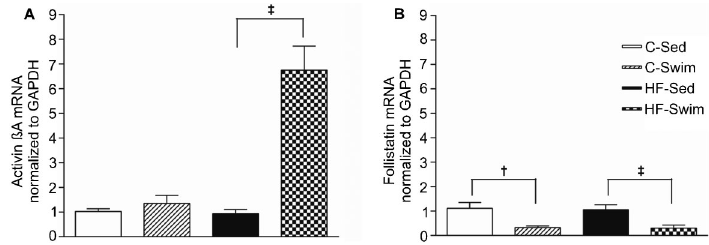
Figure 3. Liver expression mRNA. A , Activin b A and B , follistatin mRNA expression in liver of Wistar rats. Data are reported as means±SE for n=6-7 rats/group. { P , 0.05, sedentary control group (C-Sed) vs exercised control group (C- Swim); { P , 0.05, sedentary high-fat diet group